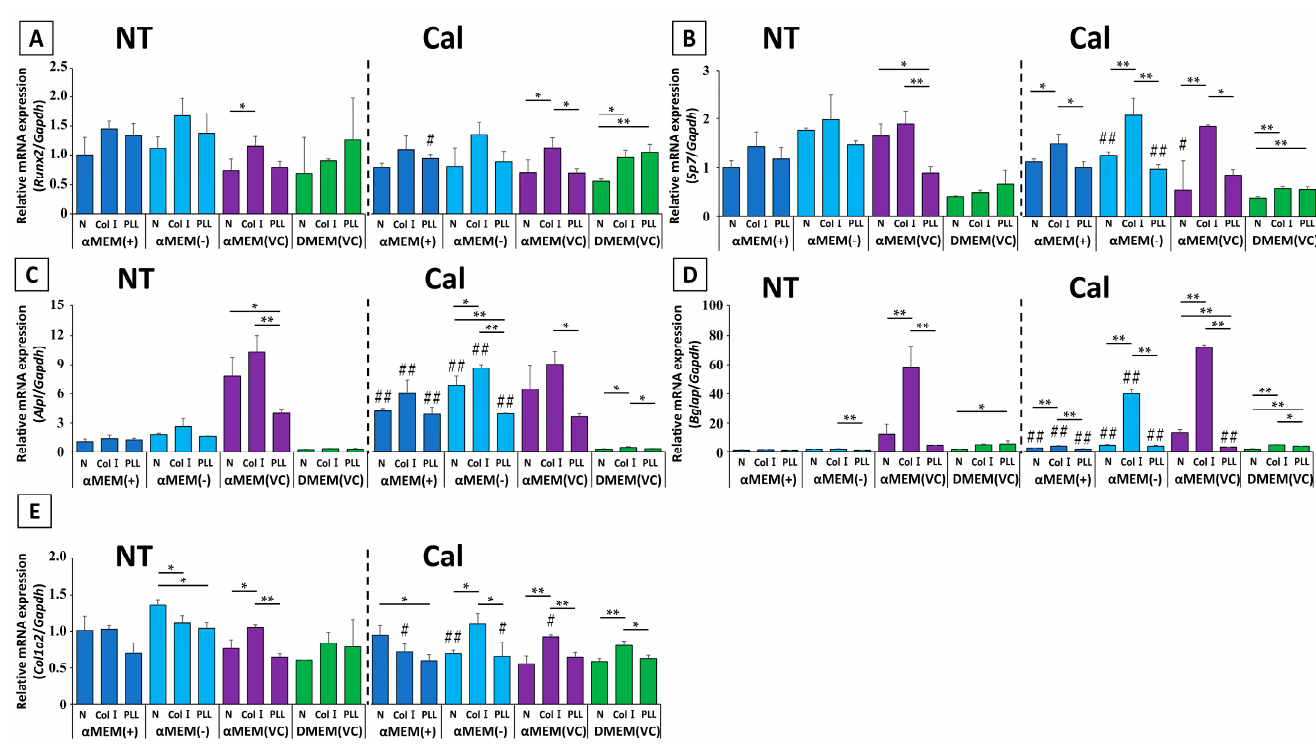
Figure 6. Comparison of the mRNA expression of ( A ) Runx2 , ( B ) Sp7 , ( C ) Alpl , ( D ) Bglap , and ( E ) Col1a2 at 7 d after calcification induction in MC3T3-E1 cells cultured with different media and different cell culture substrates. Target gene expression was normalized to Gapdh expression. The expression levels in MC3T3-E1 cells were compared with MC3T3-E1 cells cultured on nontreated (NT) α MEM (+) on normal (N), non-coated plates ( n = 3, * p < 0.05; ** p < 0.01; # p < 0.05; ## p < 0.01). * Comparison among plates under the same media conditions; ## comparison between two groups of the same NT and calcification (Cal) media in each plate.